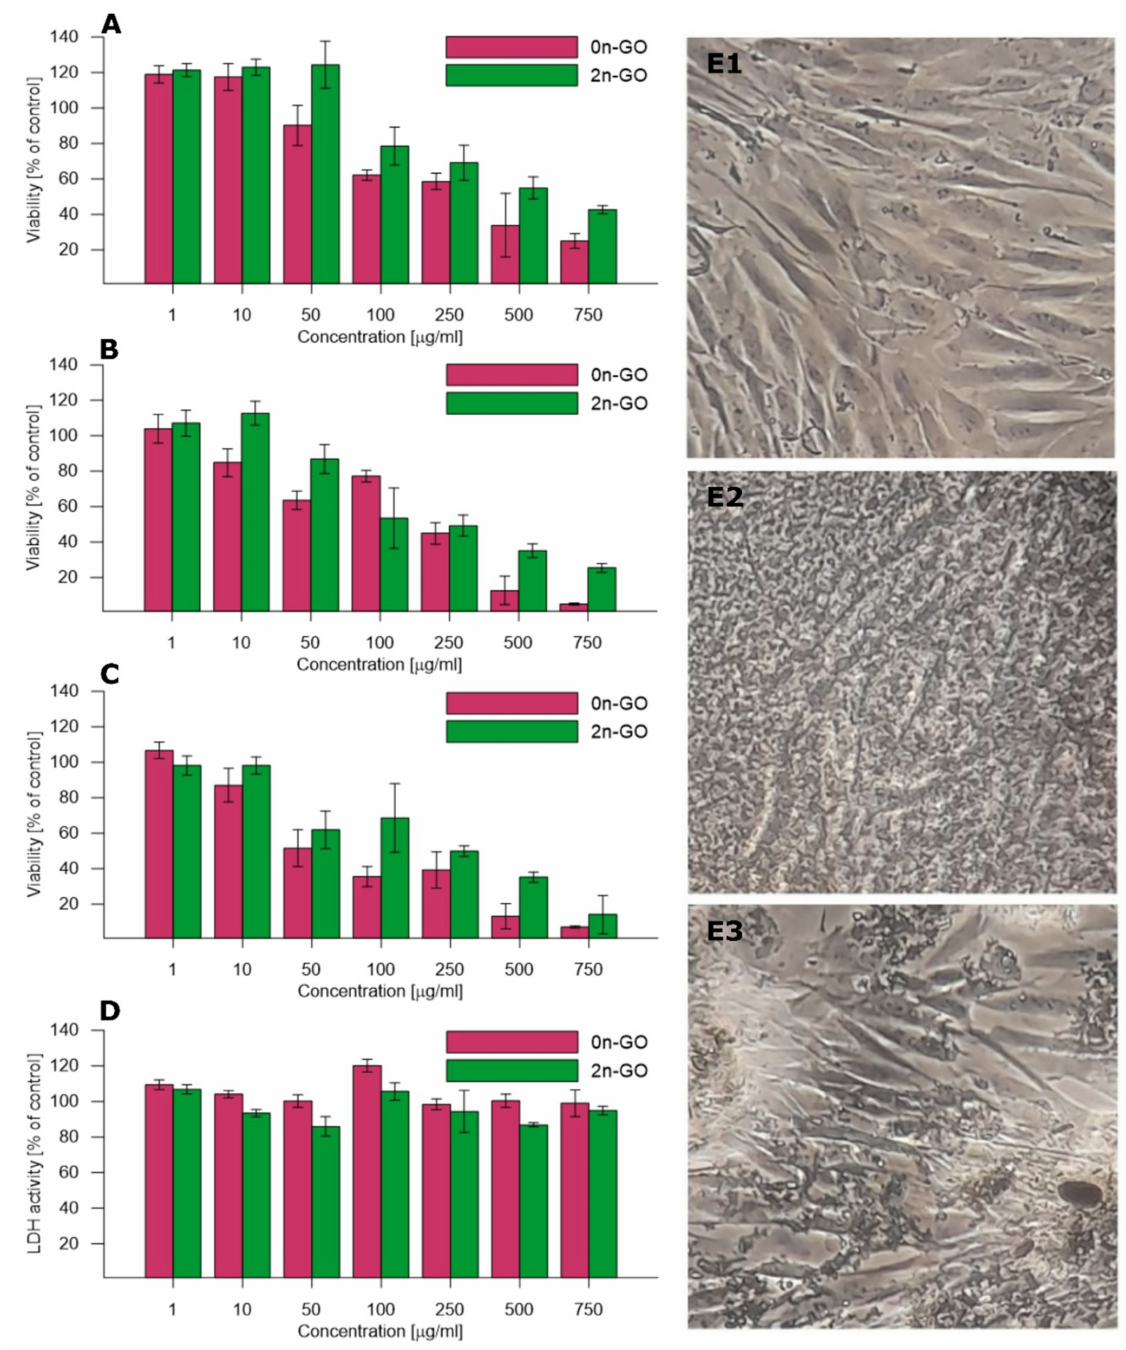
Figure 6. Comparison of 0n- and 2n-GO toxicity towards human dermal fibroblasts: results of the MTT test after ( A ) 24, ( B ) 48, and ( C ) 72 h, respectively (cell viability related to control cells without GO supplementation); ( D ) LDH activity (related to control cells without GO supplementation). Optical microscopic images of HDF cell line: ( E ) 1—control cells, 2—cells cultured with 0n-GO solution, and 3—cells cultured with 2n-GO